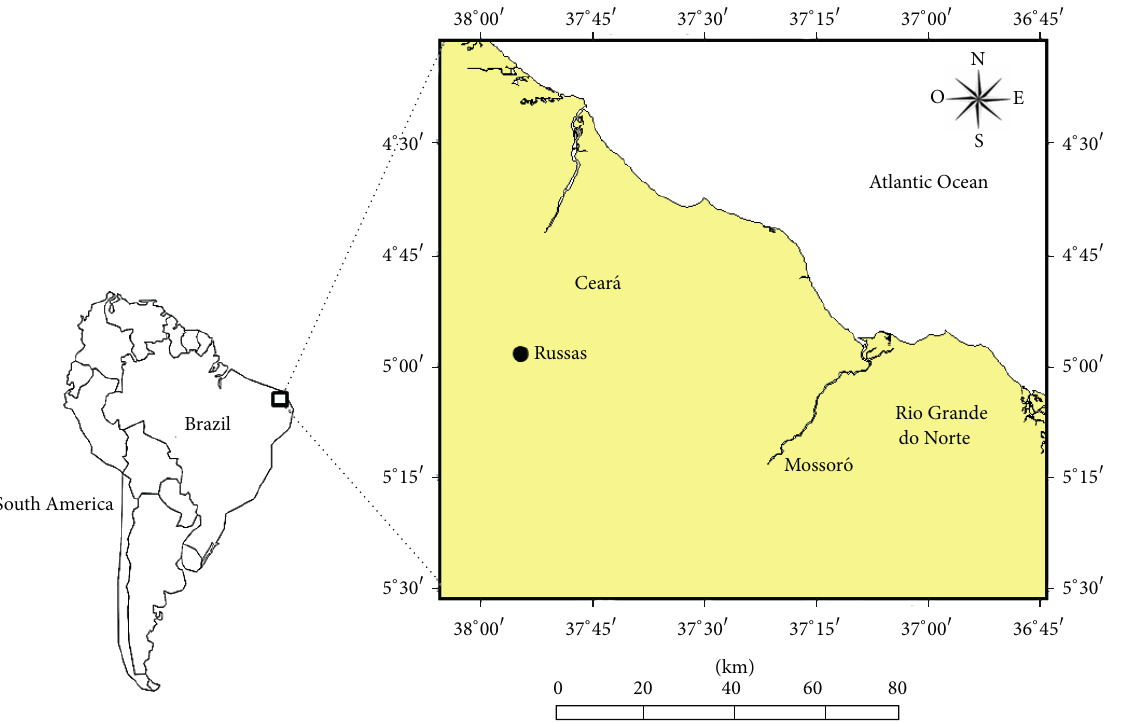
Figure 1: Location map showing the study area Russas in Cear´a,